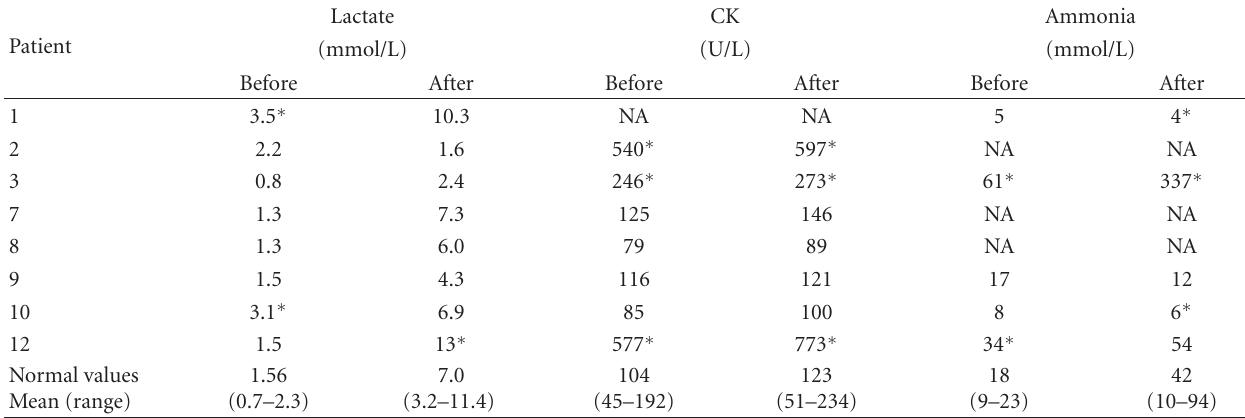
Table 2: Biochemical measurements of patients before and after the